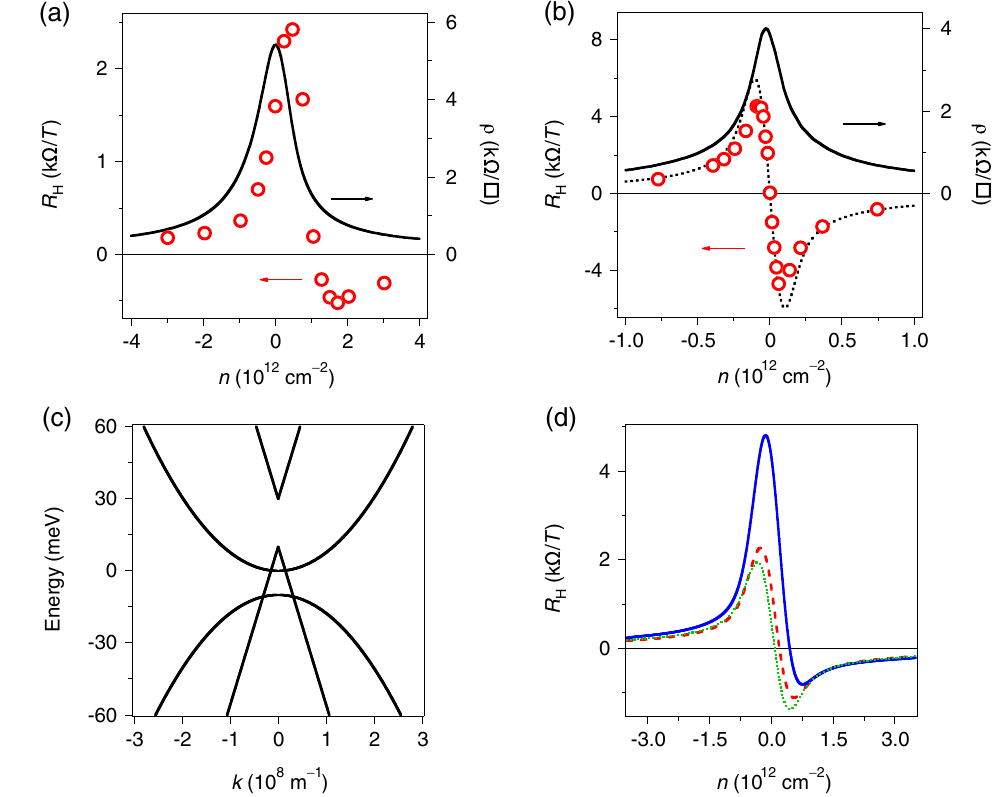
FIG. 5. (a) The measured low-field Hall coefficient, R H (red circles), and sheet resistivity, (cid:5) (black curve), of ABA-stacked trilayer graphene as a function of n , for D ¼ 0 . Uncertainty in the measurements is smaller than the symbol size. (b) R H and (cid:5) of monolayer graphene. The dotted line is R H ¼ (cid:1) 1 =ne , averaged over disorder (see text). (c) Simplified ABA band structure. (d) R H vs n calculated for the band structure in (c), for mobility ratios (cid:1) l =(cid:1) p ¼ 3 : 3 (solid blue), 1 (dashed red), and 0.3 (dotted green) (see